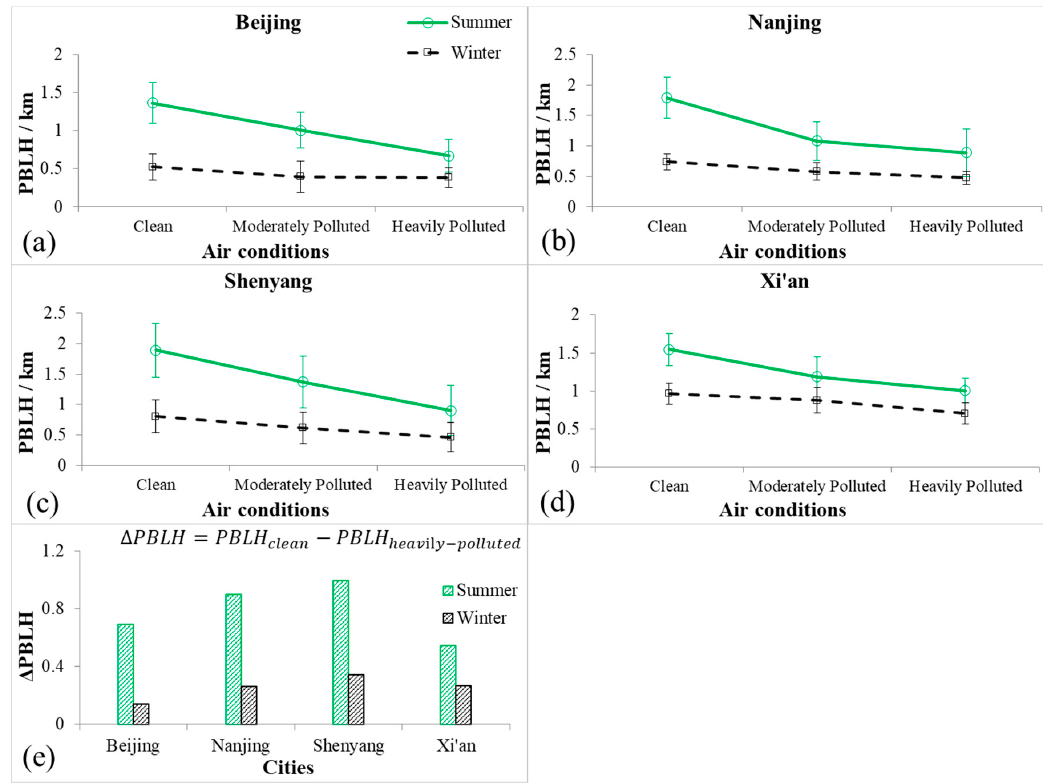
Figure 11. Planetary boundary layer height (PBLH, unit: km) under different pollution conditions calculated based on sounding data in ( a ) Beijing, ( b ) Nanjing, ( c ) Shenyang, and ( d ) Xi’an. The green lines are summertime and the black lines are wintertime. ( e ) is the PBLH difference under clean and heavy pollution conditions at each city.